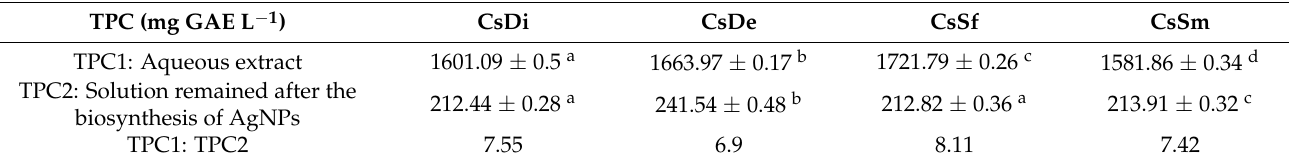
Table 2. The total phenolics content (TPC) determined for the aqueous extracts and the remaining solution after the biosynthesis of the AgNPs was performed. The analyses were performed in triplicate ( n = 3). TPC (mg GAE L − 1 ) CsDi TPC1: Aqueous extract biosynthesis of